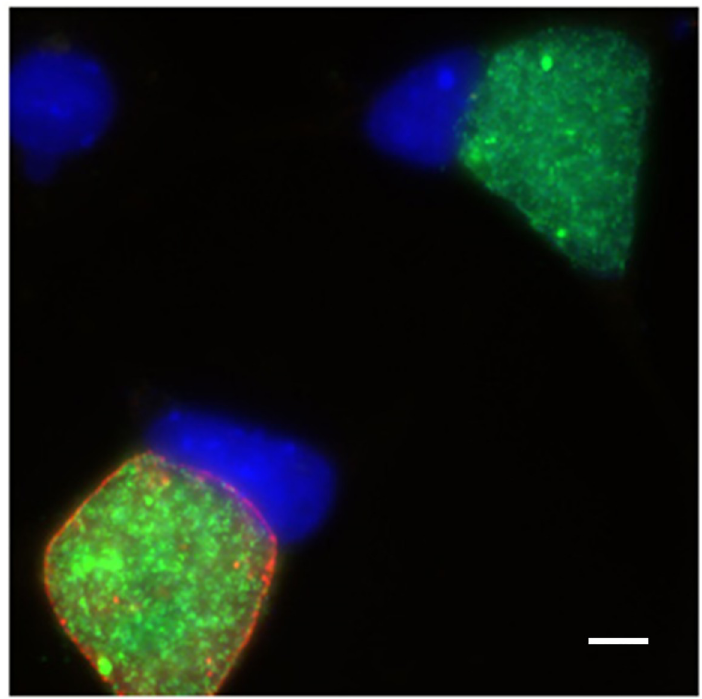
Fig 2. pBVR2 transformants exhibit heterogenous expression of IncA. GFP fluorescence of chlamydial inclusions was visualized in live cells prior to fixing and staining. The infected McCoy cells were fixed with 100% MeOH at 48 hpi and labeled with antibody against C . trachomatis IncA (red). The monolayer was then stained with DAPI to visualize host cell nuclei (blue). Scale bar represents 5 μ m.